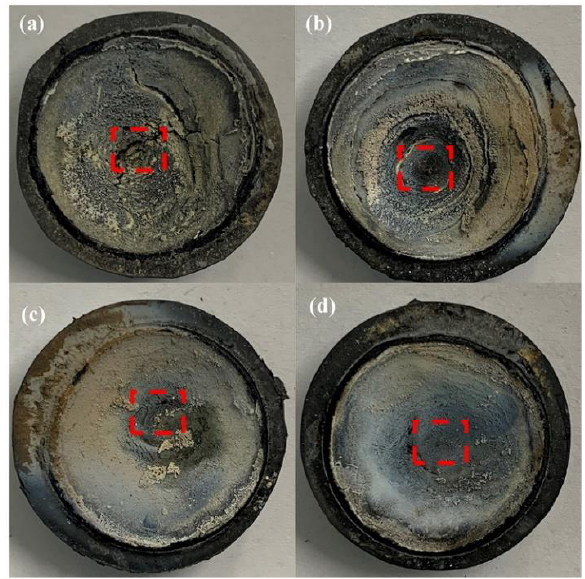
Figure 5. Macroscopic appearance of ablated composites: ( a ) SF-0.5; ( b ) SF-1; ( c ) SF-3; ( d ) SF-6. Red dotted box areas were used to identify crystal phases.